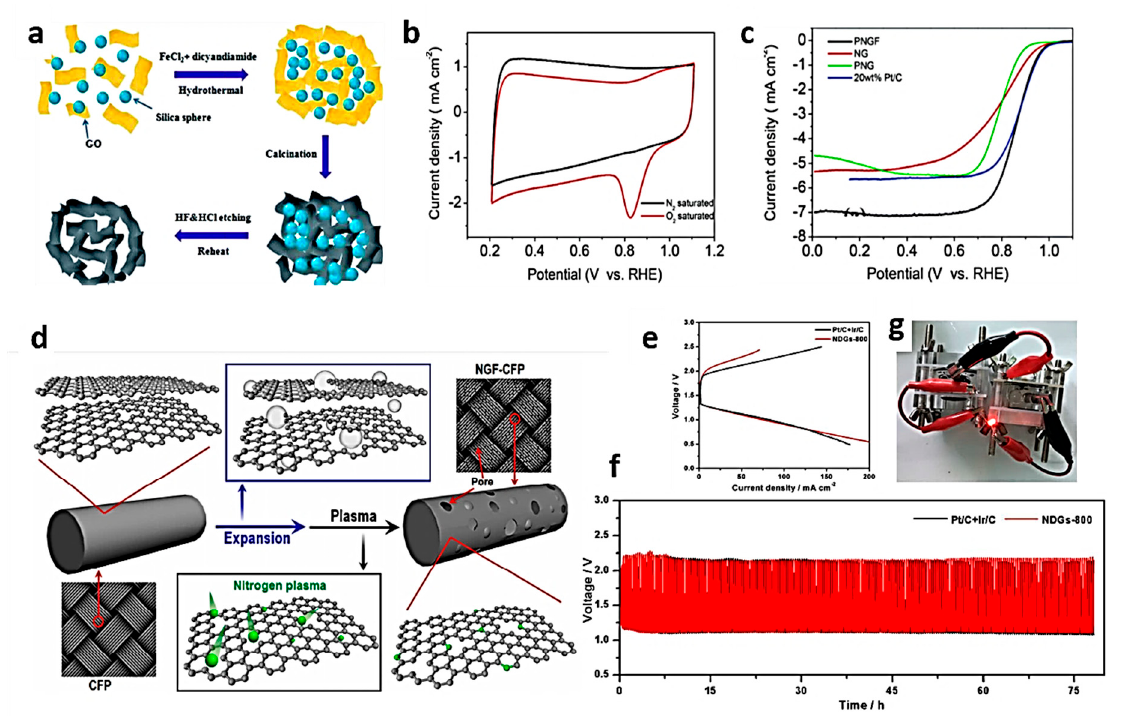
Figure 15. ( a ) Schematic representation of the synthesis procedure of PNGFs; ( b ) CV of PNGFs in 0.1 M KOH saturated with either N 2 or O 2 ; ( c ) LSVs of various electrocatalysts on a rotating disk electrode in 0.1 M KOH saturated with O 2 ; ( d ) Schematic presentation for synthesizing NGF-CFP through a facile two-step route, i.e., electrochemical expansion and nitrogen plasma treatment ( e ) Voltage profiles for the Zn-air batteries; ( f ) cycling performance at 10 mA cm -2 ; ( g ) Two serially connected Zn-air cell glowing an LED ( ≈ 3.0 V). Reprinted with permission from [151], Copyright ACS Publishers, 2017.